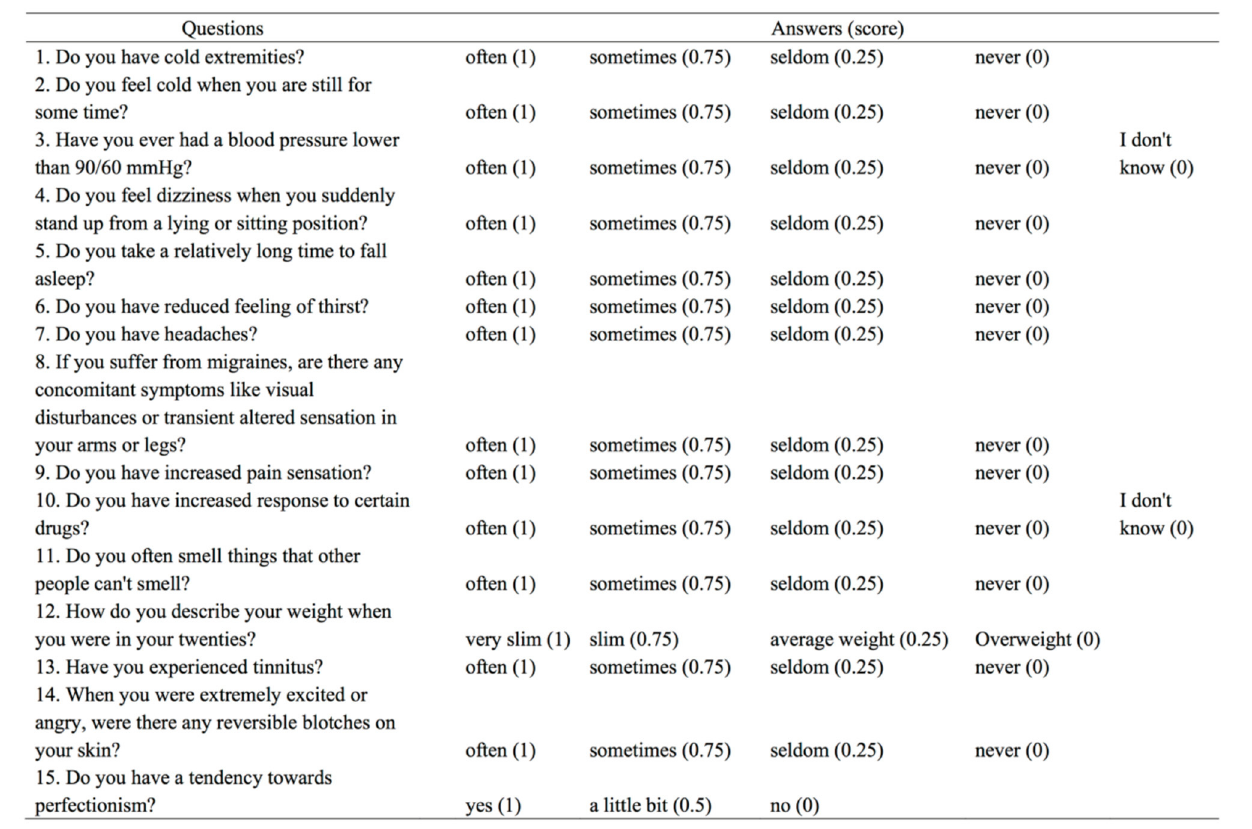
were calculated into the form of percentage after excluding the answers of “I don’t